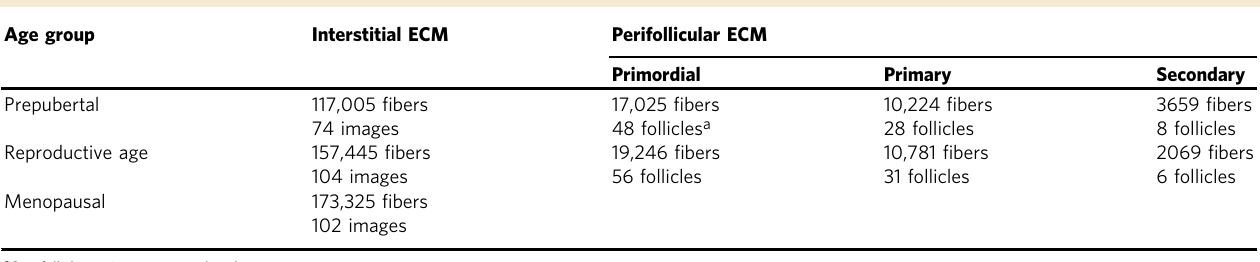
Table 1 Number of segmented and tracked fi bers in perifollicular and interstitial ECM. Age